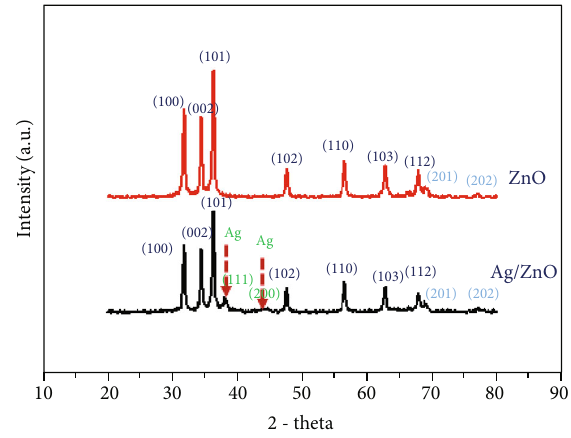
Figure 2: XRD patterns of ZnO and Ag/ZnO-10